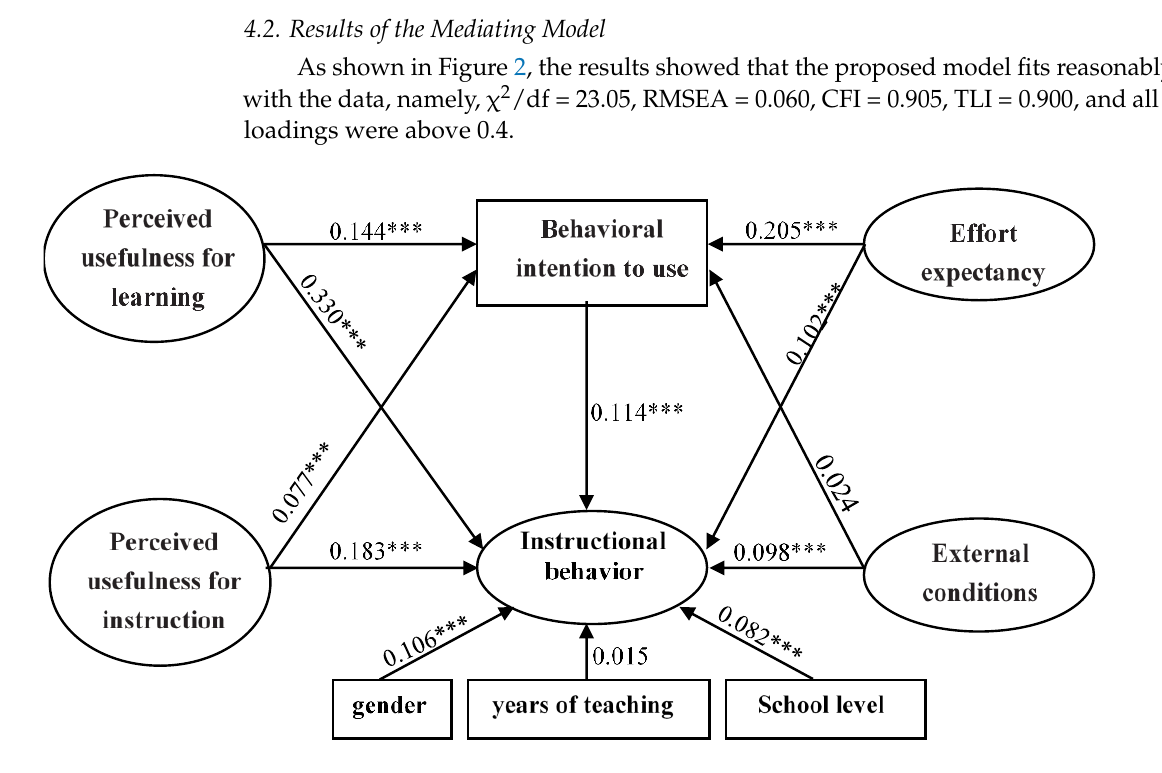
Figure 2. The resulting model of the relationship among teachers’ performance expectancy, effort expectancy, external conditions, behavioral intention, and their instructional behavior (N = 6087, χ 2 /df = 23.05, RMSEA = 0.060, CFI = 0.905, TLI = 0.900). *** means the correlation was significant at 0.001 or below ( p < 0.001).